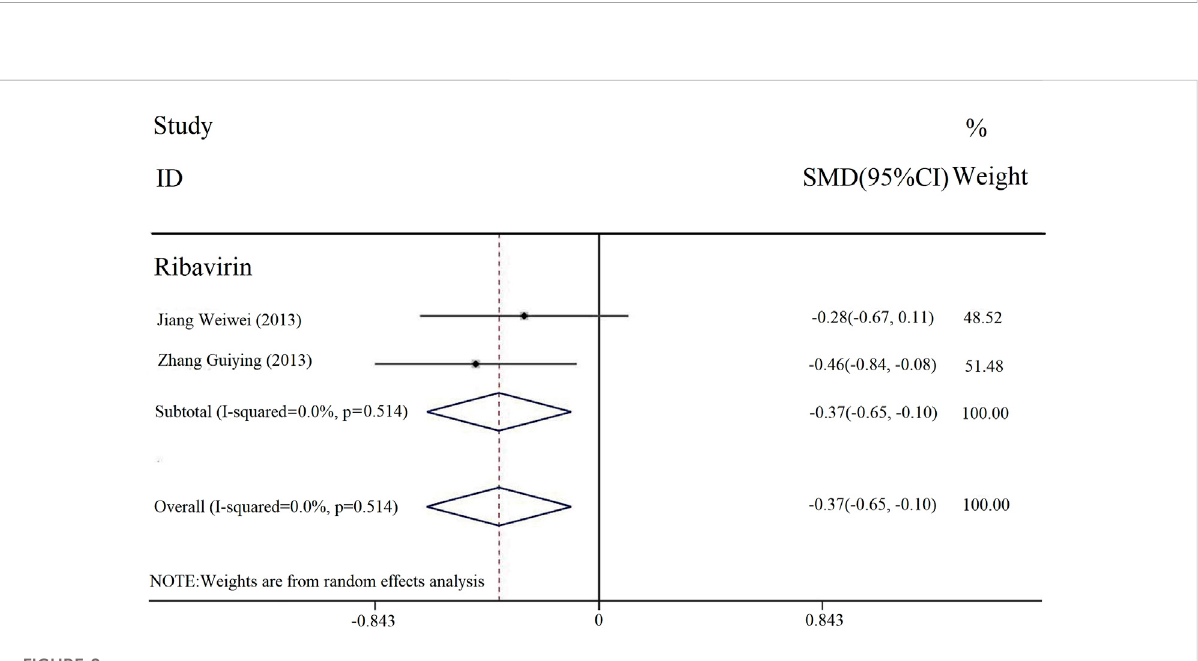
FIGURE 8 Forest plot of duration of appetite